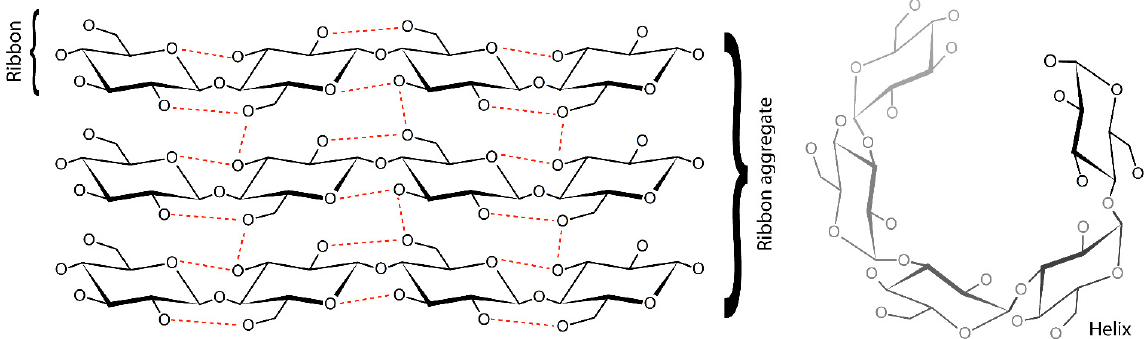
Figure 2. Schematic representation of ribbons and a ribbon aggregate ( left ), as found in cellulose, and of a helix ( right ), as found in starch. Hydrogen bonds are represented by dashed red lines.